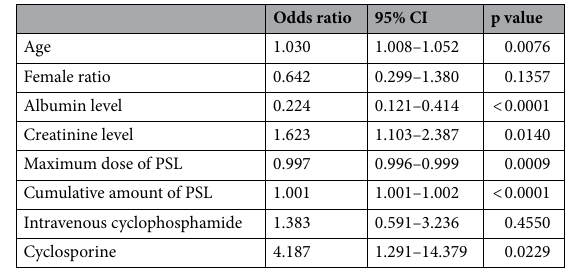
Table 4. Multivariate analysis of risk factors associated with cytomegalovirus pp65 antigen positivity.